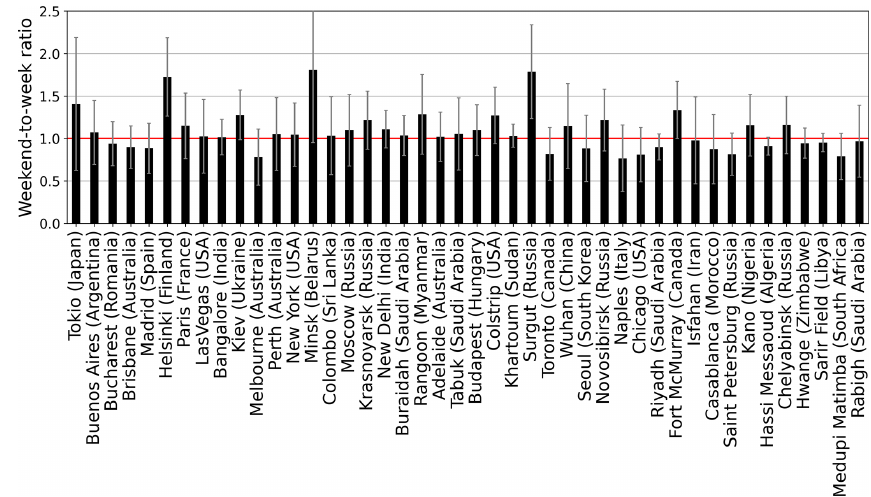
Figure A1. Weekend-to-weekday ratio of NO x lifetimes (1 March 2018 to 29 February 2020) from left to right in increasing weekend-to- weekday NO x emission ratio (see Fig. 7). Data are separated into working and weekend days for 44 source regions. Weekend can be one or two days, and those days can also differ according to religious tradition, which is considered. The red line indicates the 1 : 1 line where weekend and weekday lifetimes are equal; below the line weekday lifetimes are longer, and over the line weekend lifetimes are longer. Error bars are the standard deviation derived by the EMG fitting procedure for lifetime